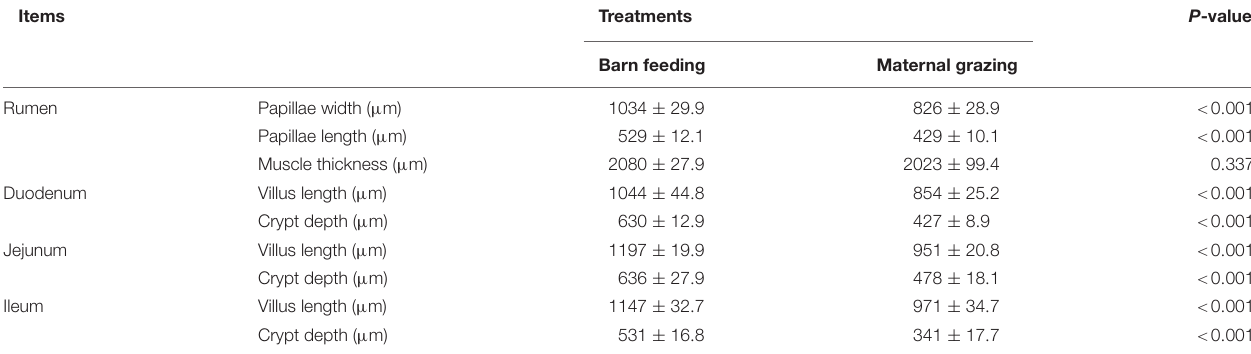
TABLE 3 | Effect of two feeding strategies (maternal grazing and barn feeding) during early life on the ruminal and intestinal morphology of yak calves.